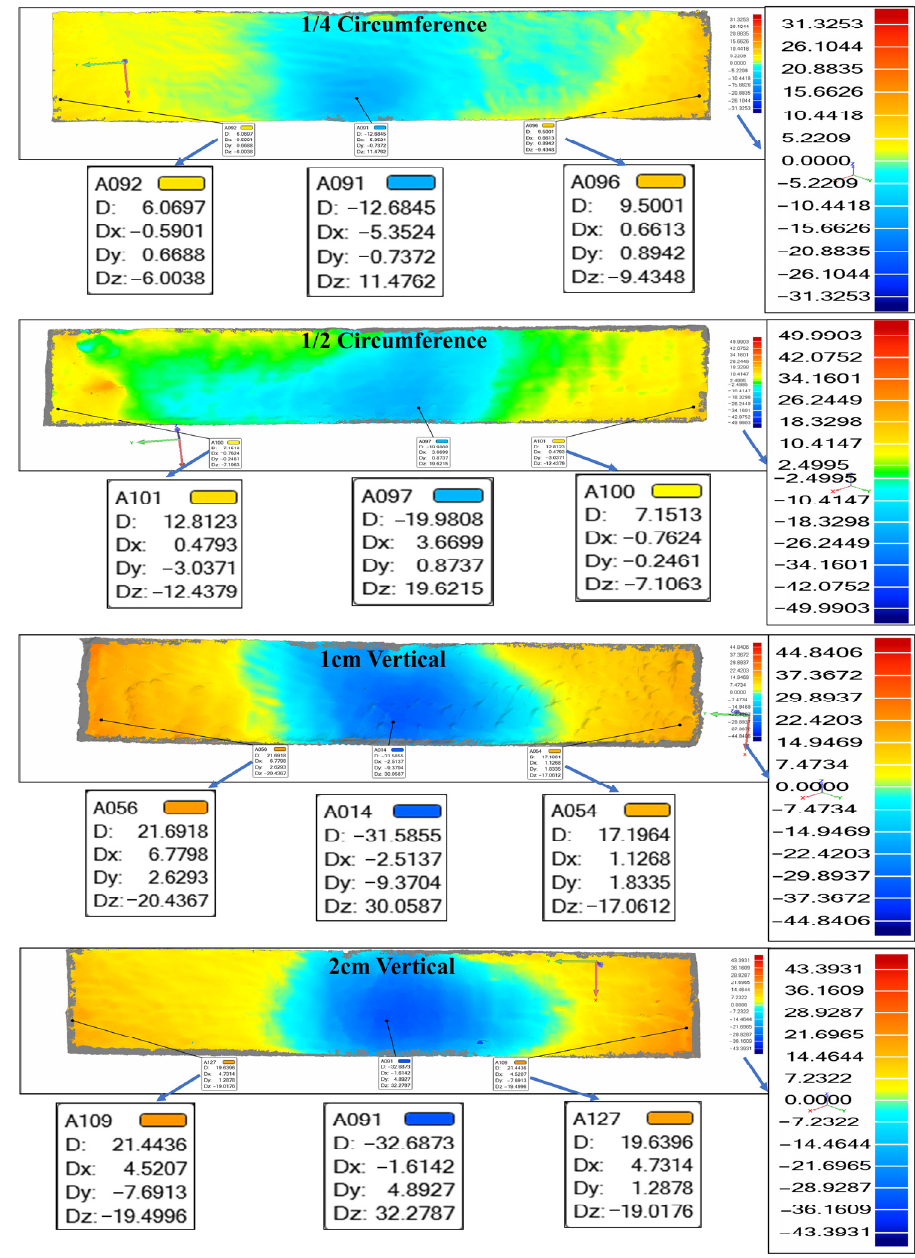
Figure 9. Three-dimensional laser scanning cloud